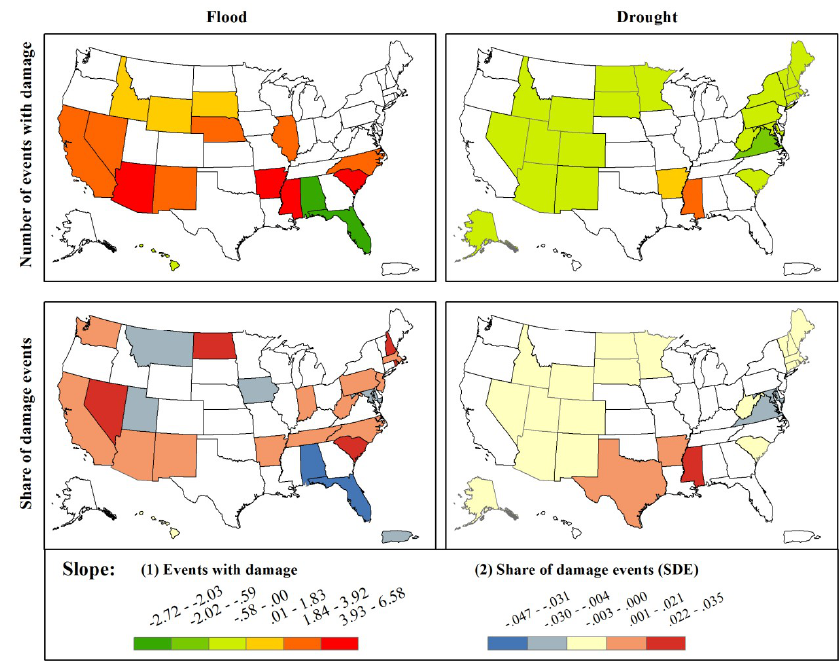
Figure 4. Trends in annual number of events with damages (NED) (first row) and share of damaging events (SDE) (second row) of floods and droughts. Only states with statistically significant relations at the 90% confidence level are shown.